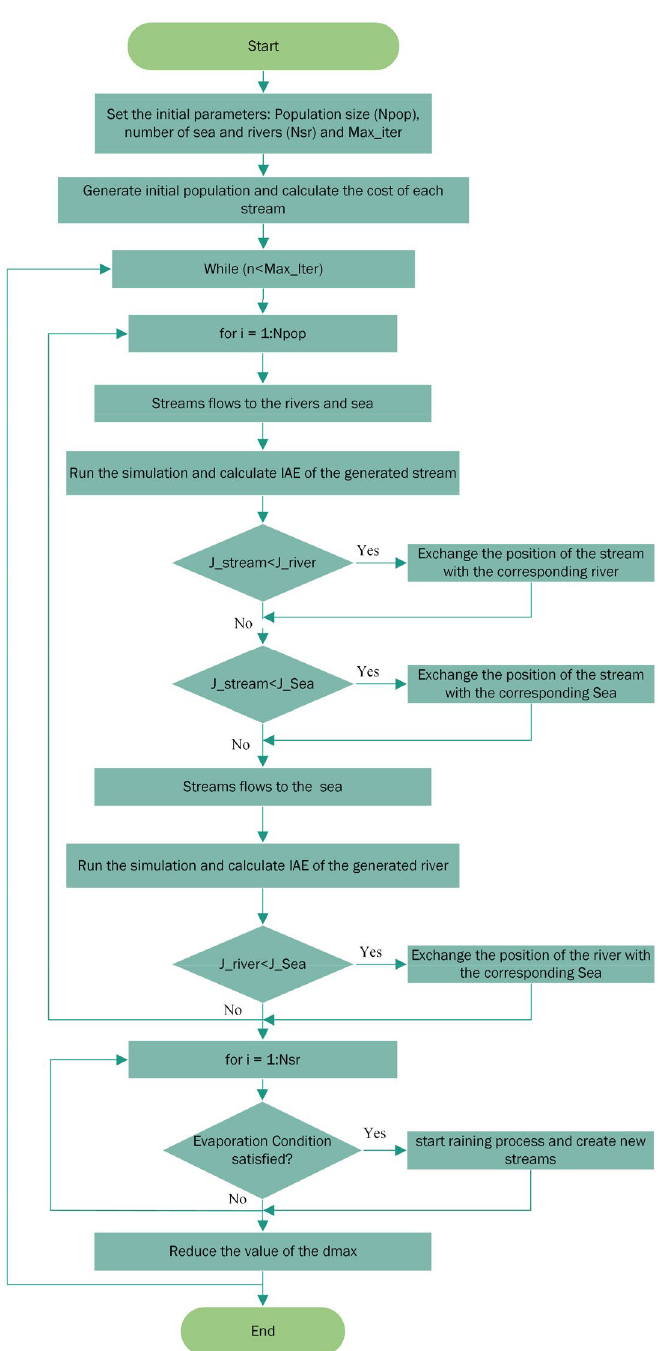
Fig. 14 Schematic of the PID